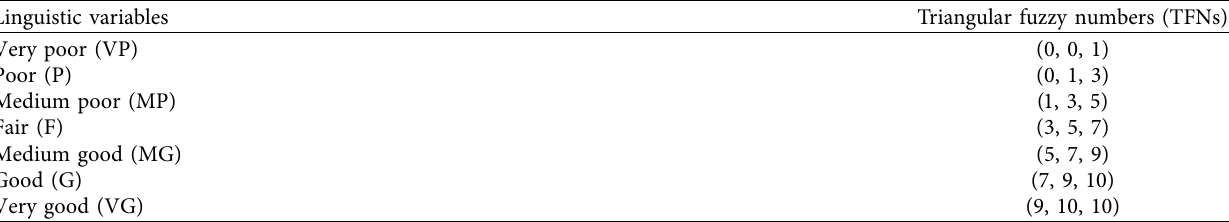
Table 8: For the evaluation of options, linguistic variables and TFNs are used. Linguistic variables